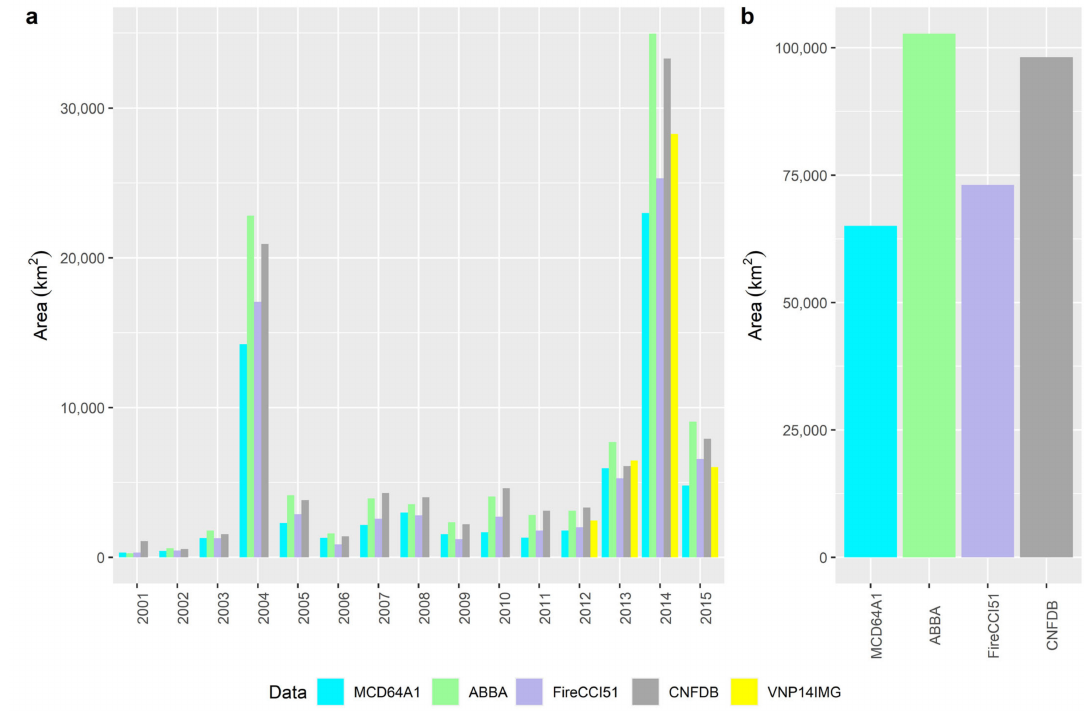
Figure 3. Comparisons of ( a ) annual total area and ( b ) grand total area of burned areas as mapped by the MCD64A1, ABBA, FireCCI51, CNFDB, and VNP14IMG data over areas in Canada north of 60 ◦ N. The grand total area of burned areas as mapped by VNP14IMG is not visualized in ( b ) because of its shorter temporal